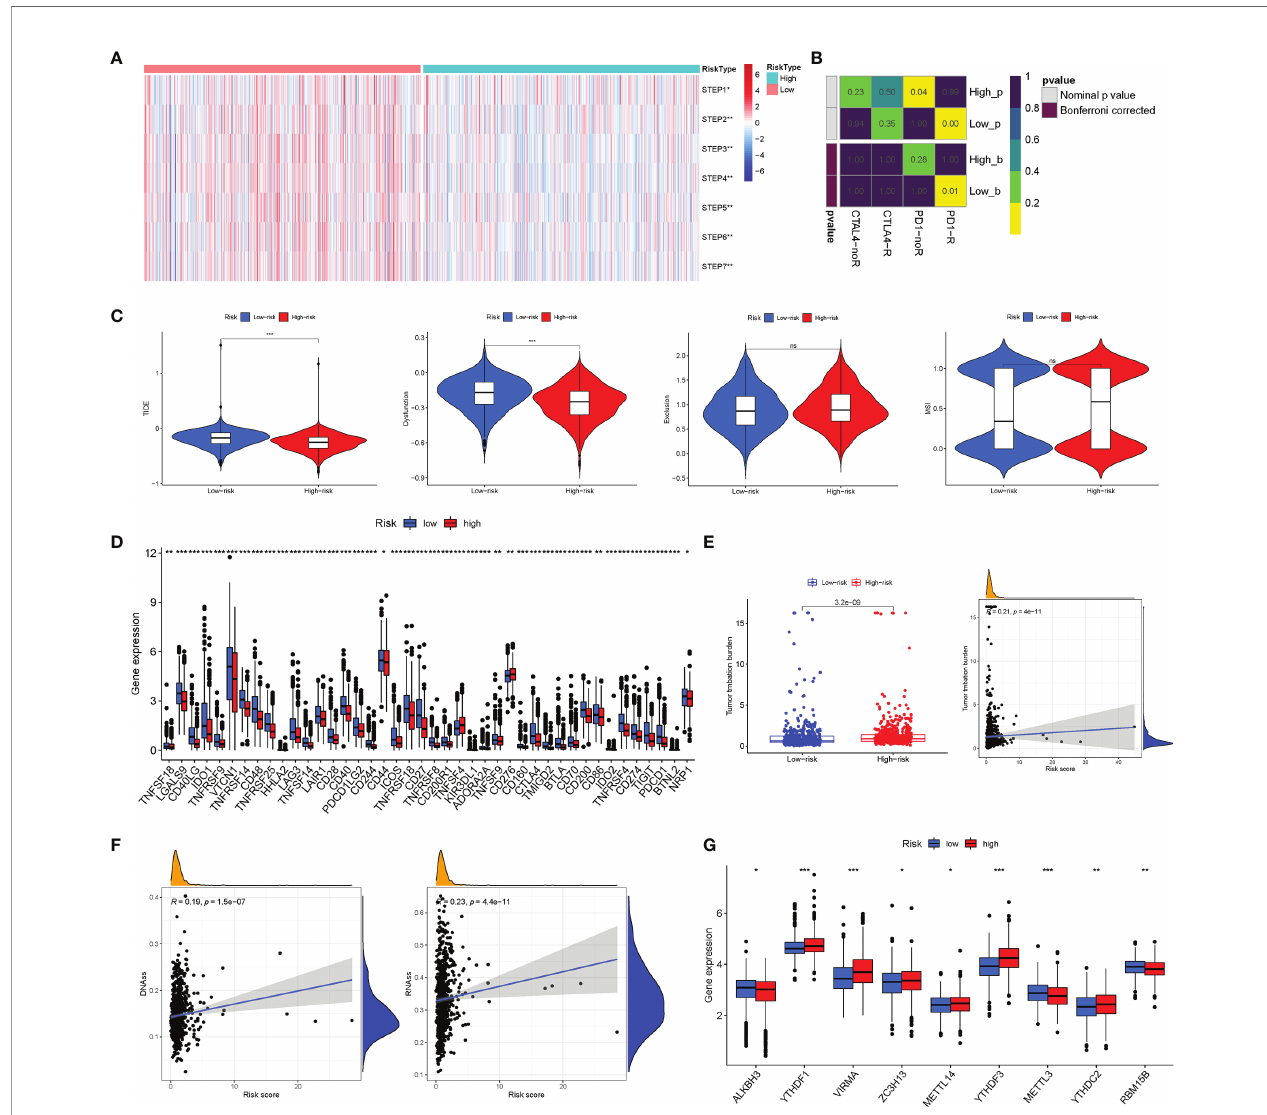
FIGURE 10 | Analysisofimmunotherapy effect and methylation patterns. (A) The possibility of anti-PD1and anti-cytotoxicT lymphocyte-associatedprotein 4 (CTLA4) response to immunotherapy was evaluated between the high- and low-risk groupsthroughthe SubMAP algorithm. (B) The single-sample gene setenrichment analysis (ssGSEA)algorithm was performed to calculate the scores of theseven steps of the tumor-immunecycle. (C) The tumor immune dysfunction andexclusion (TIDE) algorithm was used to predict the response of The Cancer GenomeAtlas (TCGA)-breast cancer (BC)patients to immunotherapy. (D) The distribution ofimmune checkpoints was signi fi cantly different between the high- and low-riskgroups. (E) The BC patients in the high-risk group had higher tumor mutation burden (TMB) than that ofBC patients in the low-risk group. (F) Pearson ’ s correlation between the RNA stemness score (RNAss) and DNA stemness score (DNAss)and the risk score. (G) The different expressions of m6A-relatedgenes between the high- and low-risk groups. *P < 0.05; **P < 0.01; ***P < 0.001; ns (nonsigni fi